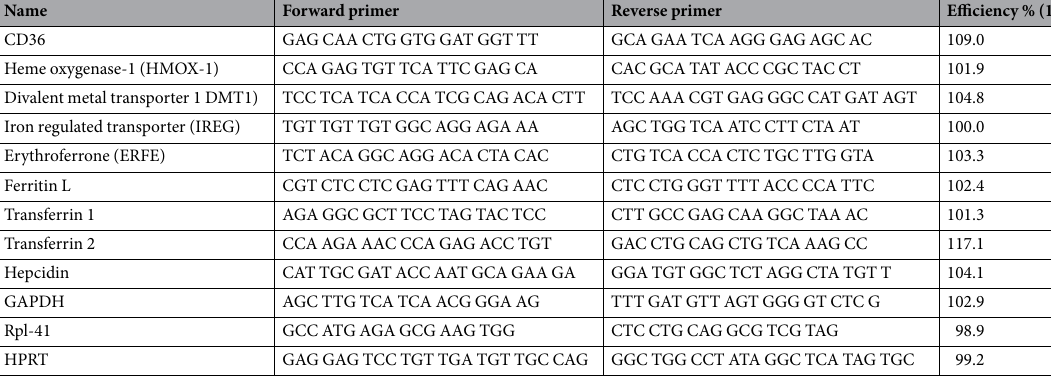
Table 1. List of primers used in this study. All primers were obtained from Life sciences (Cergy-Pontoise, France). (1): The efficiency was calculated using cDNA obtained from the spleen of control animals, excepted for EPO, which was tested using cDNA obtained from the